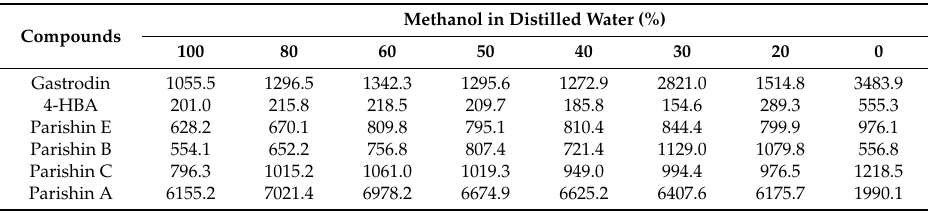
Table 2. Extraction yields ( µ g/g dw) of parishin derivatives from fully mature M. tricuspidata fruit as extracted with different methanol